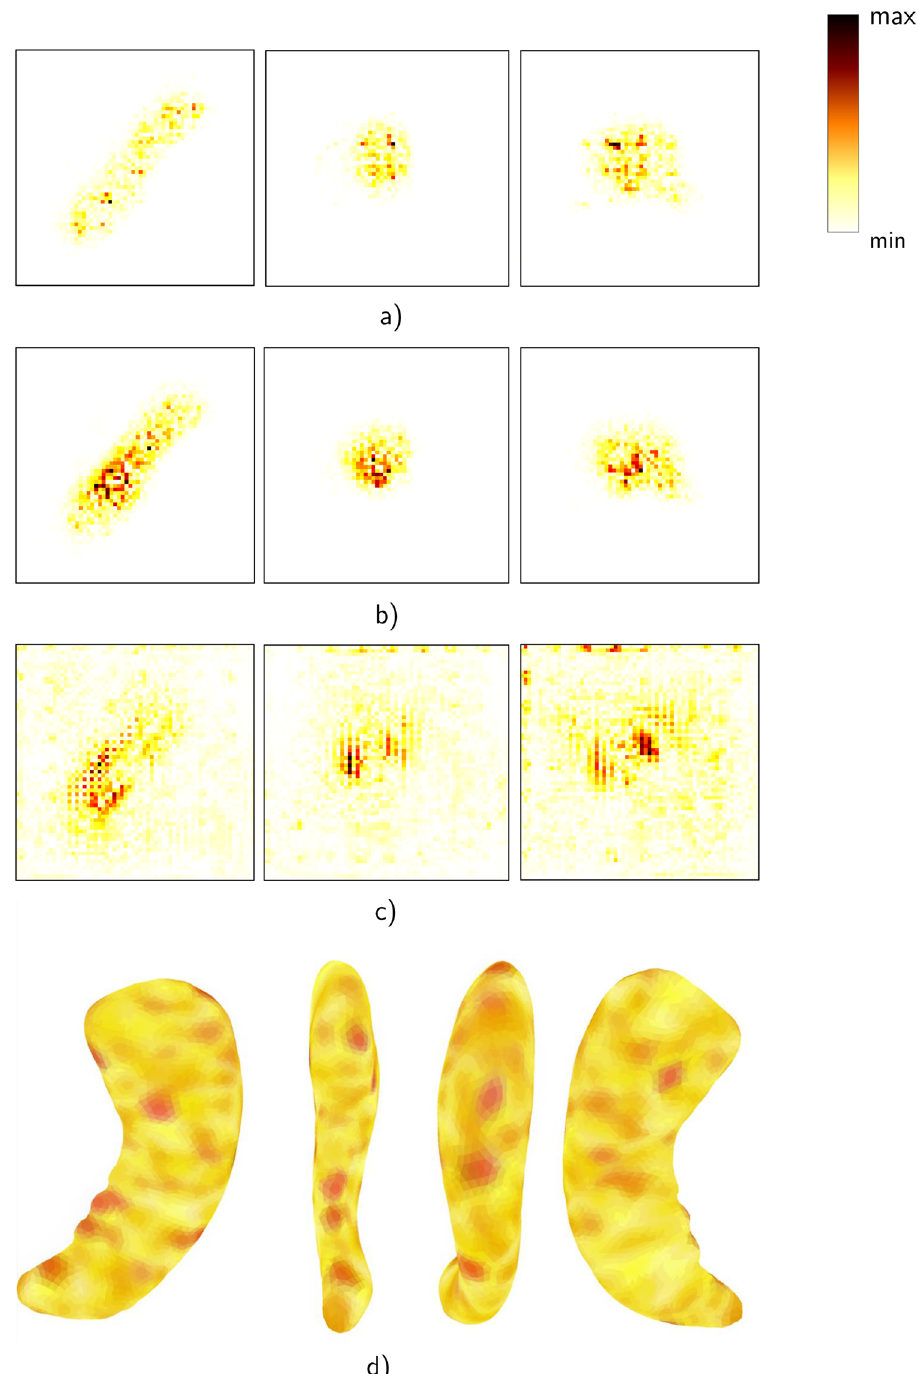
Figure 3. Average of integrated gradients computed across the AD population for the volume ( a – c ) and mesh representations ( d ). ( a – c ) Shown for only on slice in sagital, coronal and axial (respectively): ( a ) volumetric mask, ( b ) texture, and ( c ) ROI. ( d ) Views (from left to right): superior, medial, lateral and